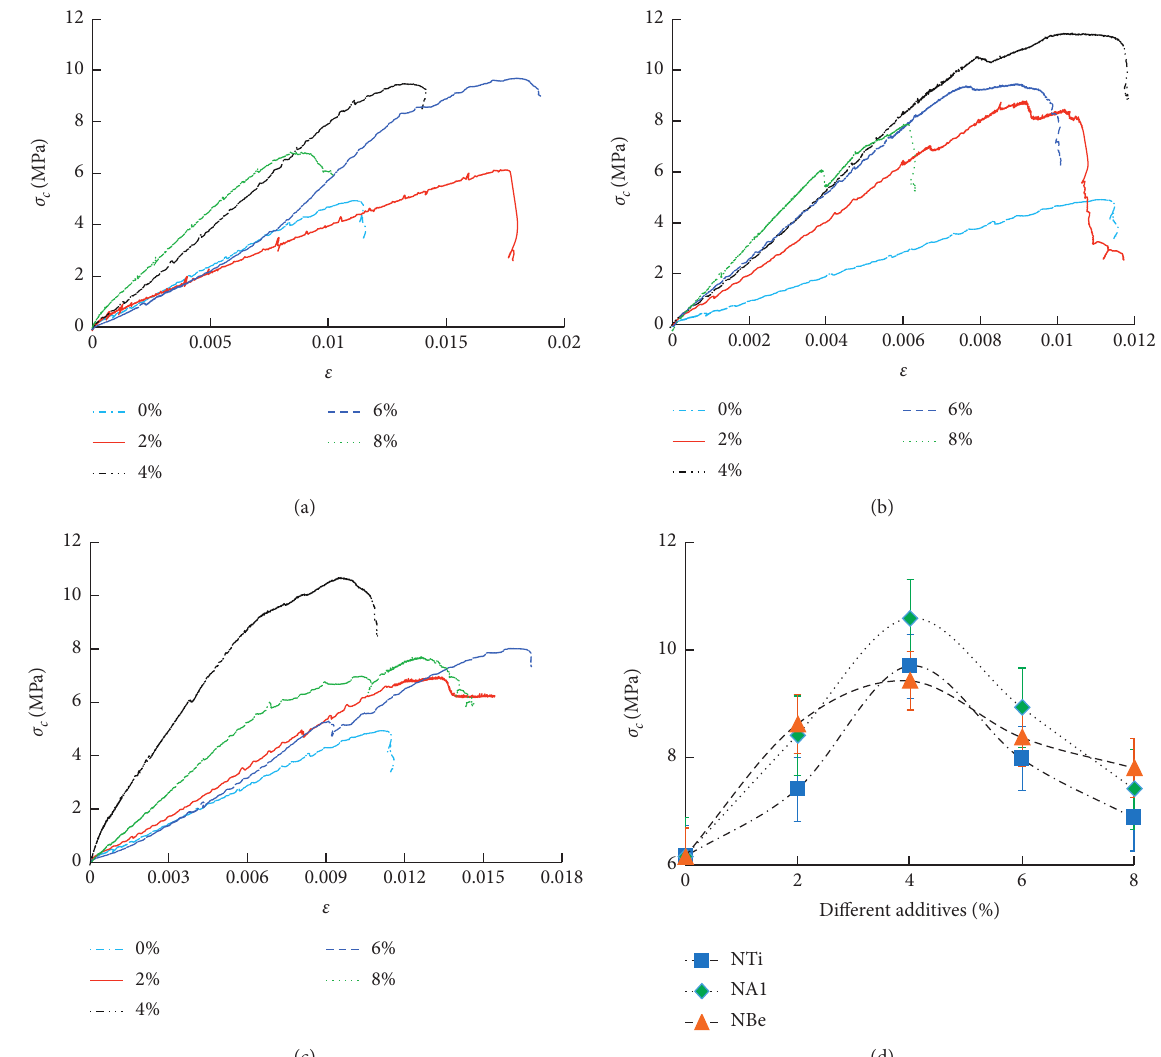
Figure 6: The effects of different nanoadditives on the stress of similar material